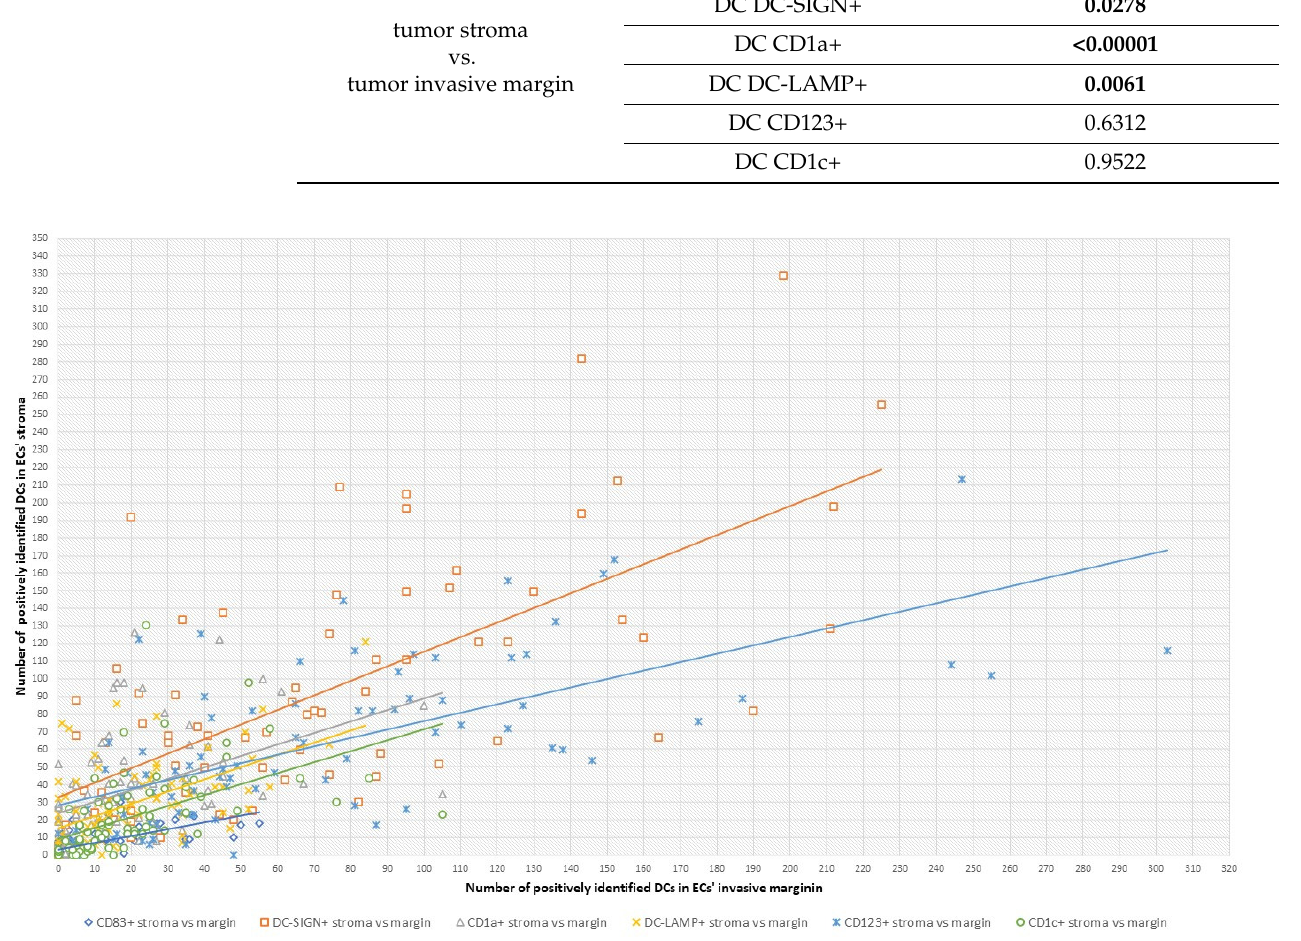
Figure 5. Correlations between DC counts in ECs’ stroma and invasive margin. This graph shows the numbers of DCs that were positively identified for stated antibodies in the tumor stroma (Y-axis) and invasive margin (X-axis) plotted against each other. Trend lines assigned to a pair of variables are the same color as the variables’ data points. The Spearman rank correlation test was used for statistical analysis. The obtained Spearman’s rank correlation coefficient ρ and p -value for every pair of correlated variables are listed below. A p -value < 0.05 was considered statistically